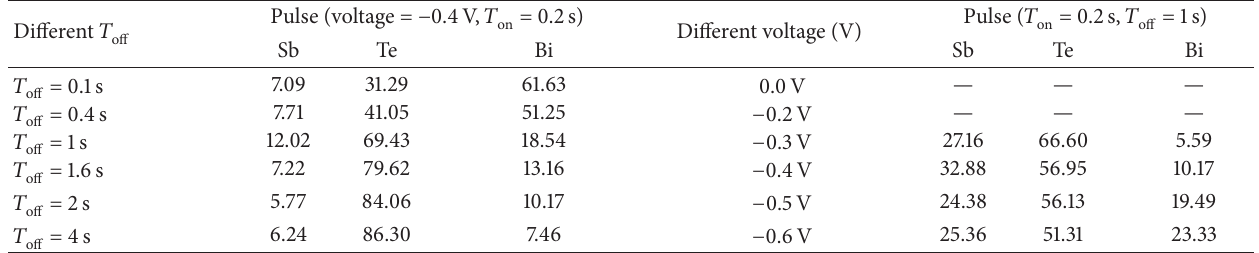
Table 2: Effects of pulse deposition parameters on the composition of the ( Bi,Sb ) 2−𝑥 Te 3+𝑥 materials; (a) the bias voltage was set at − 0.4V, 𝑇 on was set at 0.2 s, and 𝑇 off was changed from 0.1s to 4 s. (b) 𝑇 on and 𝑇 off were set at 0.2s and 1s, and the pulse voltage was changed. Pulse (voltage = − 0.4 V, 𝑇 on = 0.2 s) Pulse ( 𝑇 on = 0.2 s, 𝑇 off = 1s) Different voltage (V) Different 𝑇 off Sb Te Bi Sb Bi 𝑇 off =